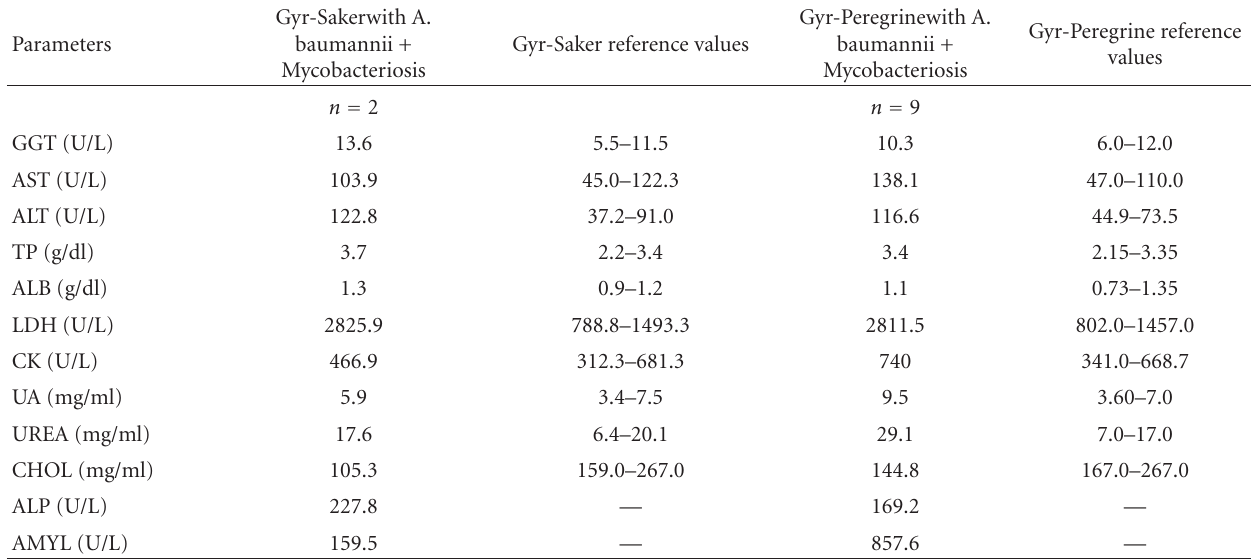
Table 3: Mean of blood biochemistry results of Gyr-Saker and Gyr-Peregrine hybrid falcons tested positive for A. baumannii and